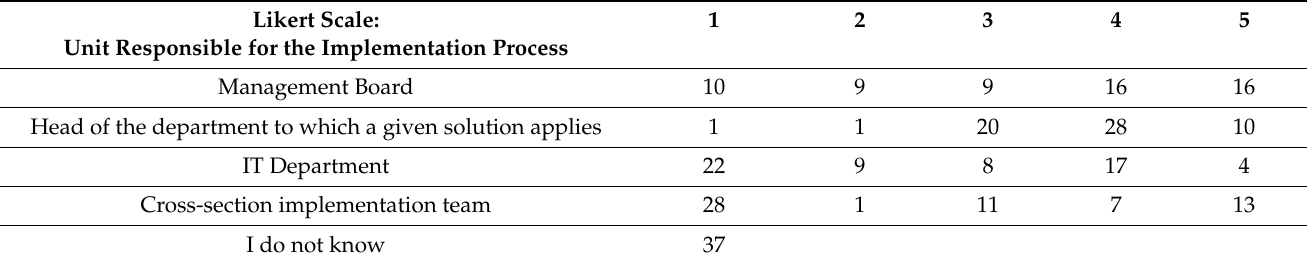
Table 12. The unit and the degree of its responsibility for the implementation of Industry 4.0 solutions. Likert